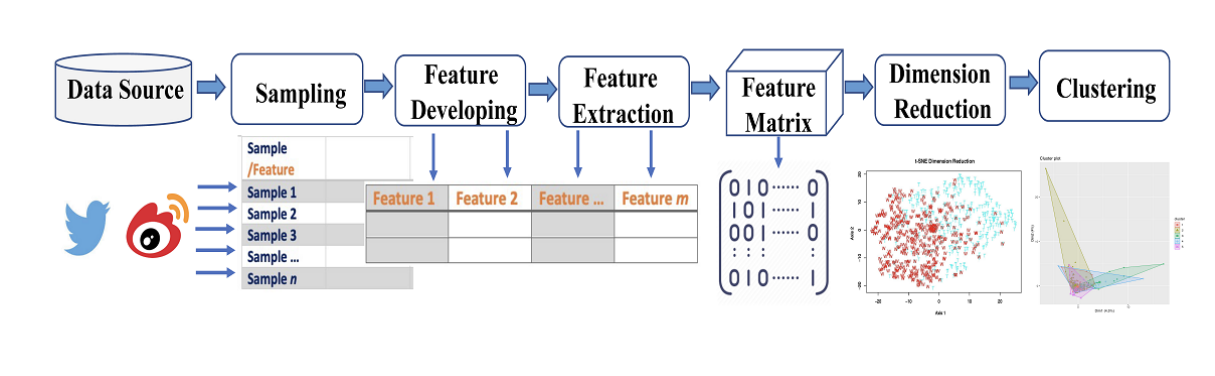
Figure 1. Conceptualized social media content feature extraction and analysis workflow. Sampling was performed with specific application programming interfaces in Python. Feature developing, extraction, and quantification were performed manually by our group. Subsequent analyses were performed in